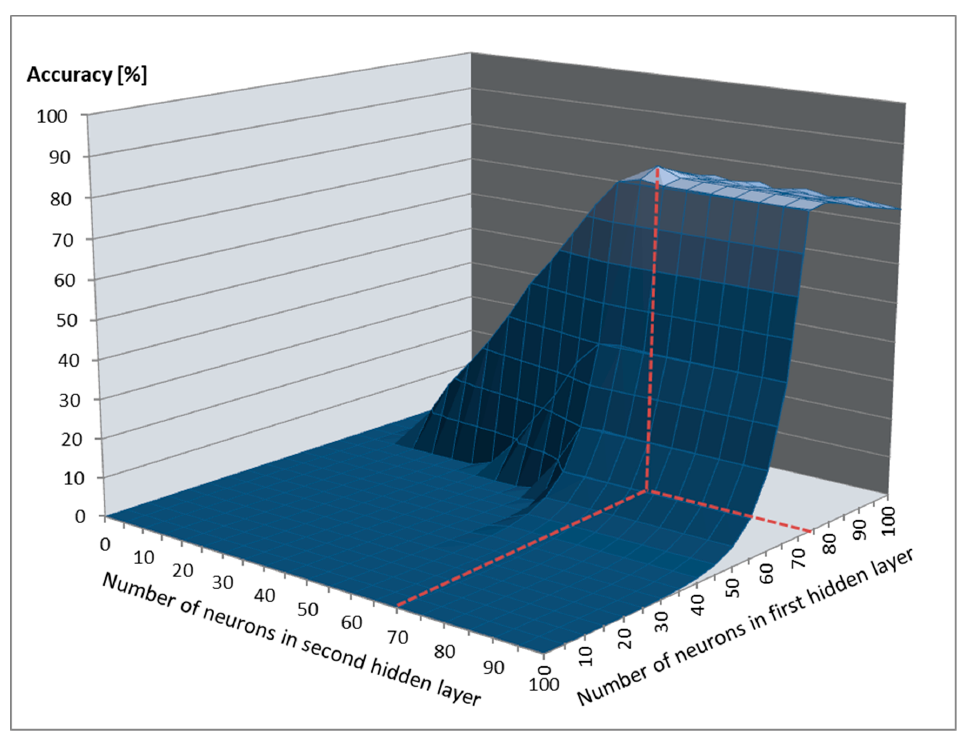
Figure 7. Prediction accuracy based on the number of neurons in hidden layers.